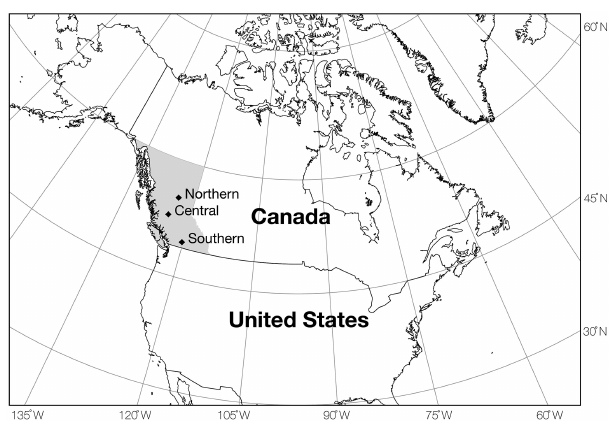
Figure 1. Three locations studied; the province of British Columbia is shaded.